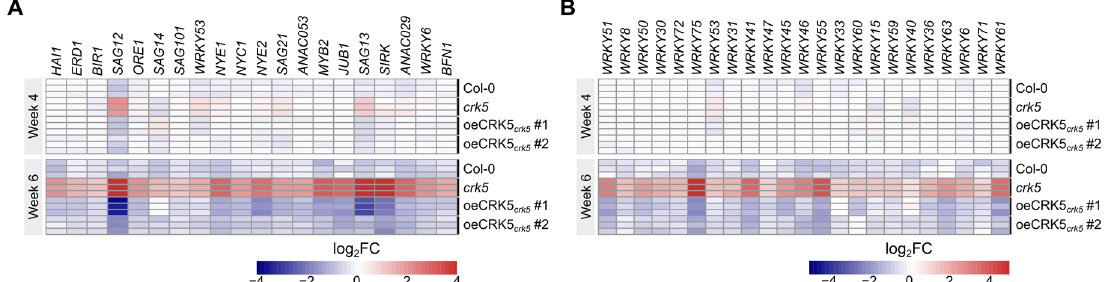
Figure 1. RNA seq analysis of plants at different ages (four and six weeks old). The study involved four genotypes: Col-0, crk5 and two complementation lines oeCRK5crk5#1, oeCRK5crk5#2. Heat map shows the expression patterns of selected senescence marker genes ( A ) and WRKY transcription factors ( B